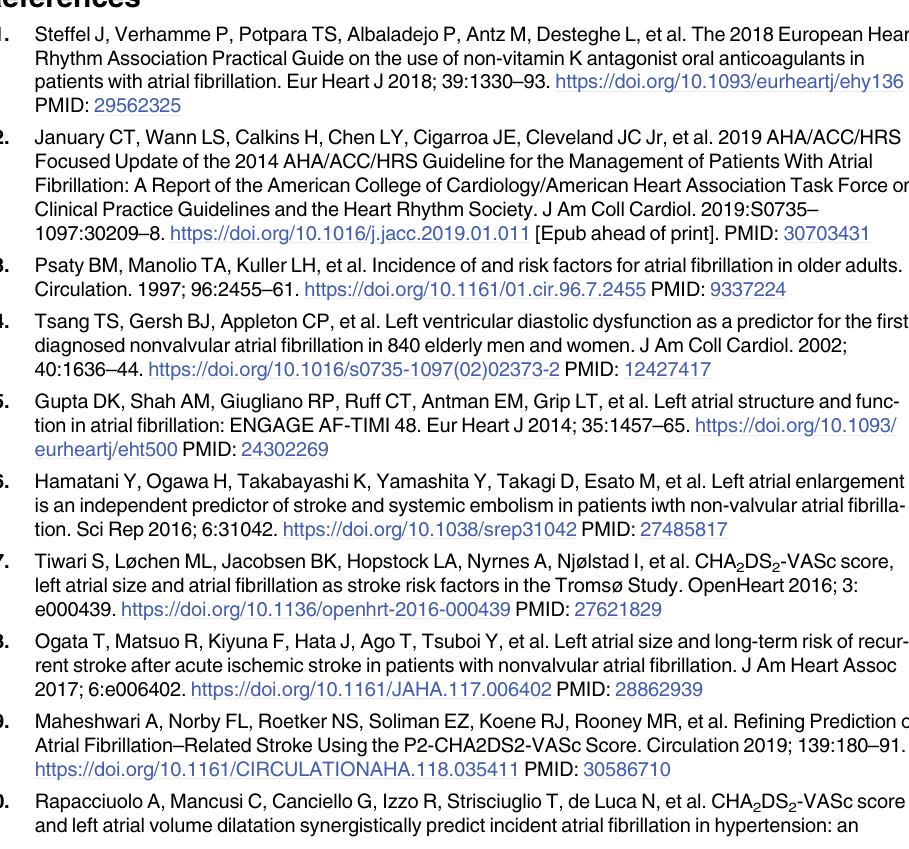
S2 Table. Hazard ratios for outcomes in patients with dilated LAD indexed to BSA ( > 26 mm/m 2